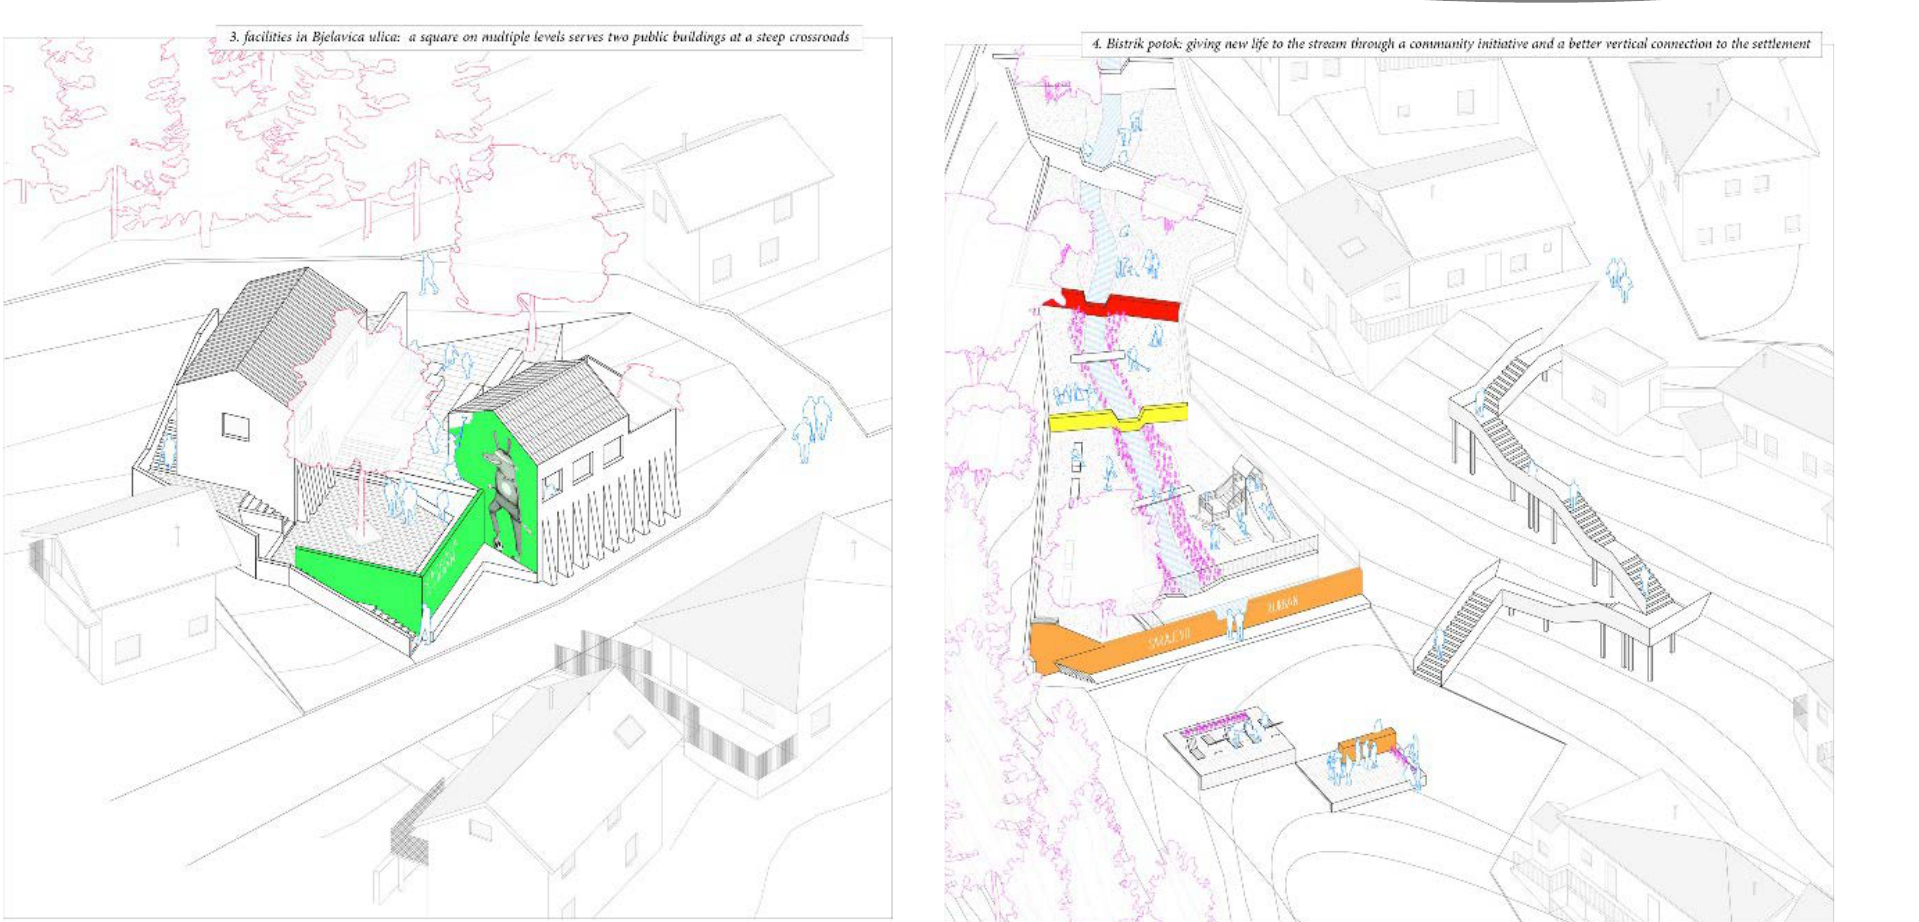
Figure 12: Some examples of the designed spaces and interventions: public facilities around a pocket square and the repurposing and new accessibility of the stream, as a new public green